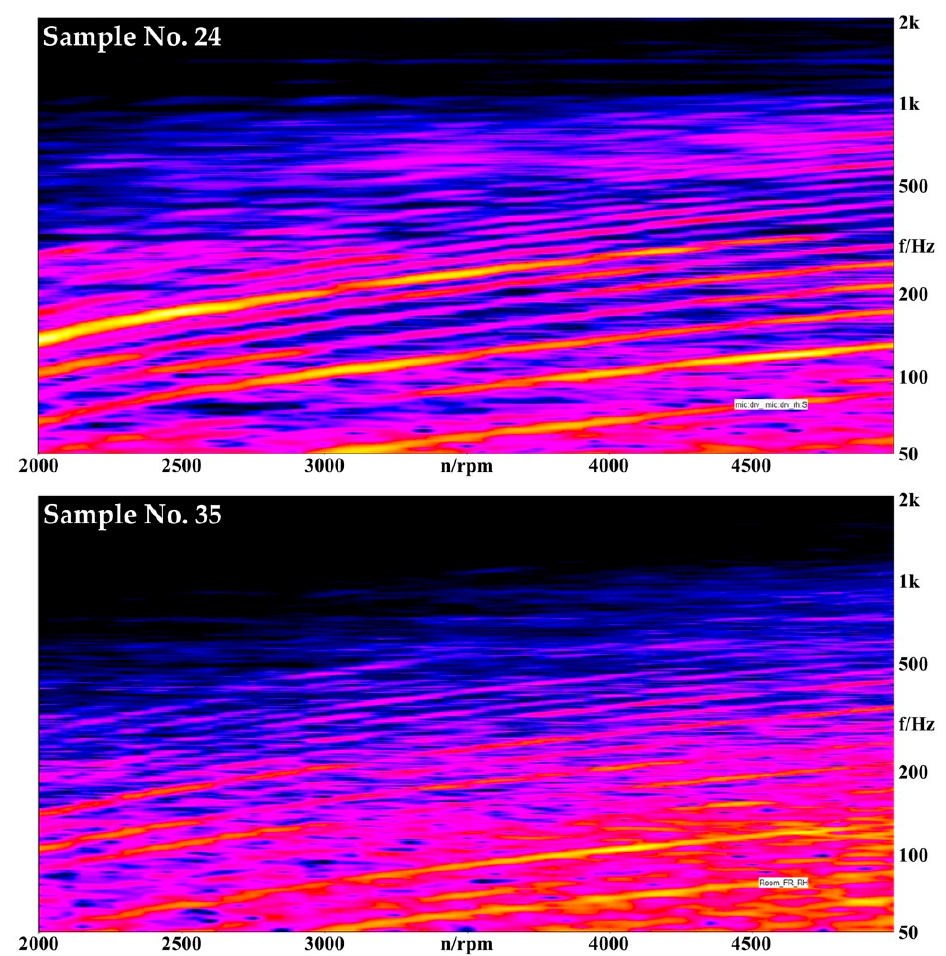
Figure 6. Results of spectrum analysis for samples with the highest (upper side) and lowest (lower side) 323 score of perceived power. 324